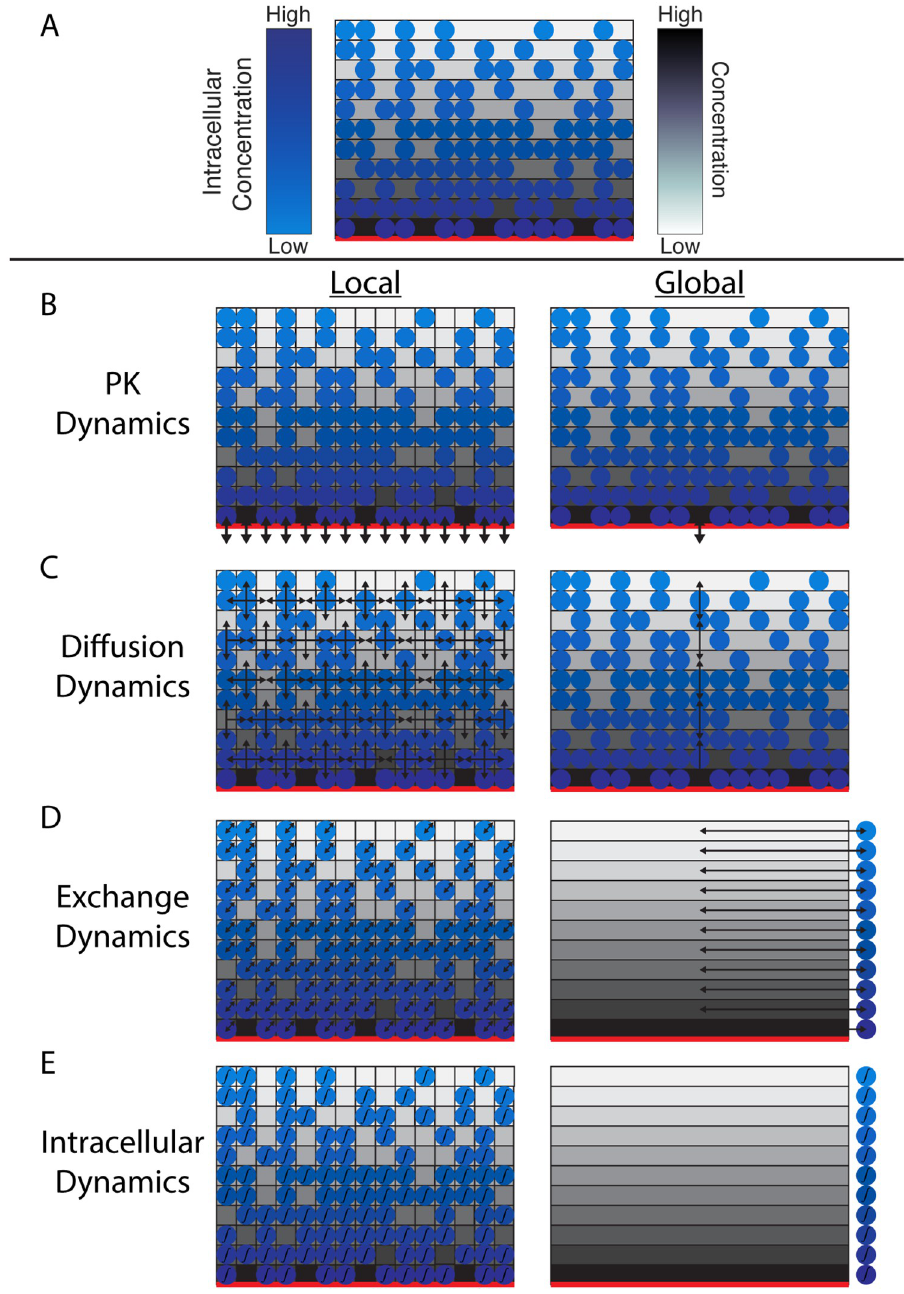
Fig 1. Schematic comparison of the two methods. A. Schematic of regions in the global method when the vasculature is at the bottom boundary. The red line along the bottom indicates the location of the blood vessel. The monochrome rectangles represent regions used in the global method. The discs represent agents in the model. The shading of each region indicates the average oxygen concentration within. The shading of each agent represents the internalized concentration. The bottom-most region is the only region containing perivascular lattice sites. All of the lattices sites in the bottom region are perivascular. B-E. Schematic comparison of how the local (left column) and global (right column) methods treat the four molecular-level dynamics. The arrows all correspond to movement of substrates. B-C. In the local/global methods, PK dynamics update perivascular sites/regions (B) and diffusion occurs between neighboring sites/regions (C). D-E. The local method solves the exchange and then intracellular dynamics for each cell individually. The global method solves these once per region using the average intracellular concentration in each R region as indicated by the single cell on the right. In E, the symbol represents the integration required to advance